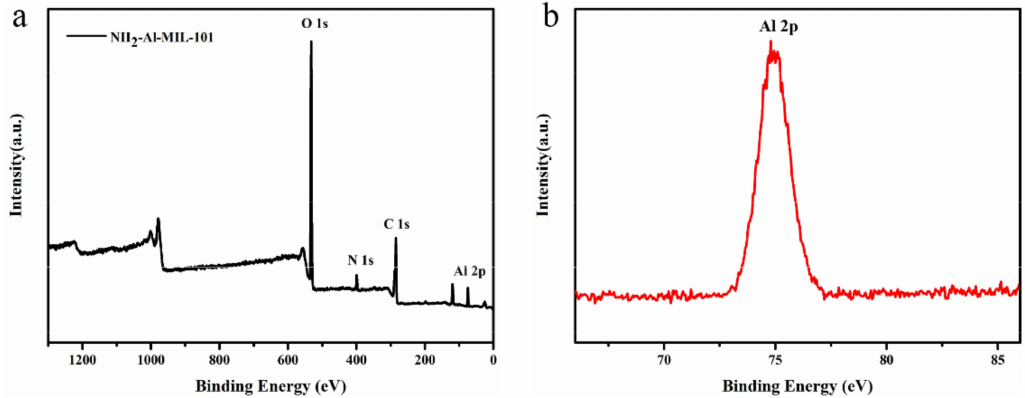
Figure 4. X-ray photoelectron spectroscopy (XPS) spectra of NH 2 -Al-MIL-101 ( a ) and Al 2p ( b